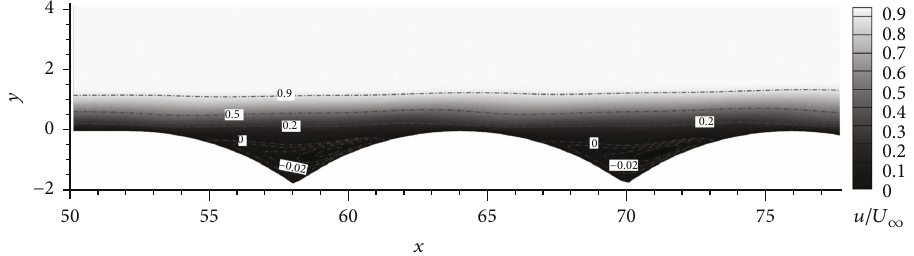
Figure 3: Velocity along the x -axis of steady fl ow in the boundary layer in literature [14].